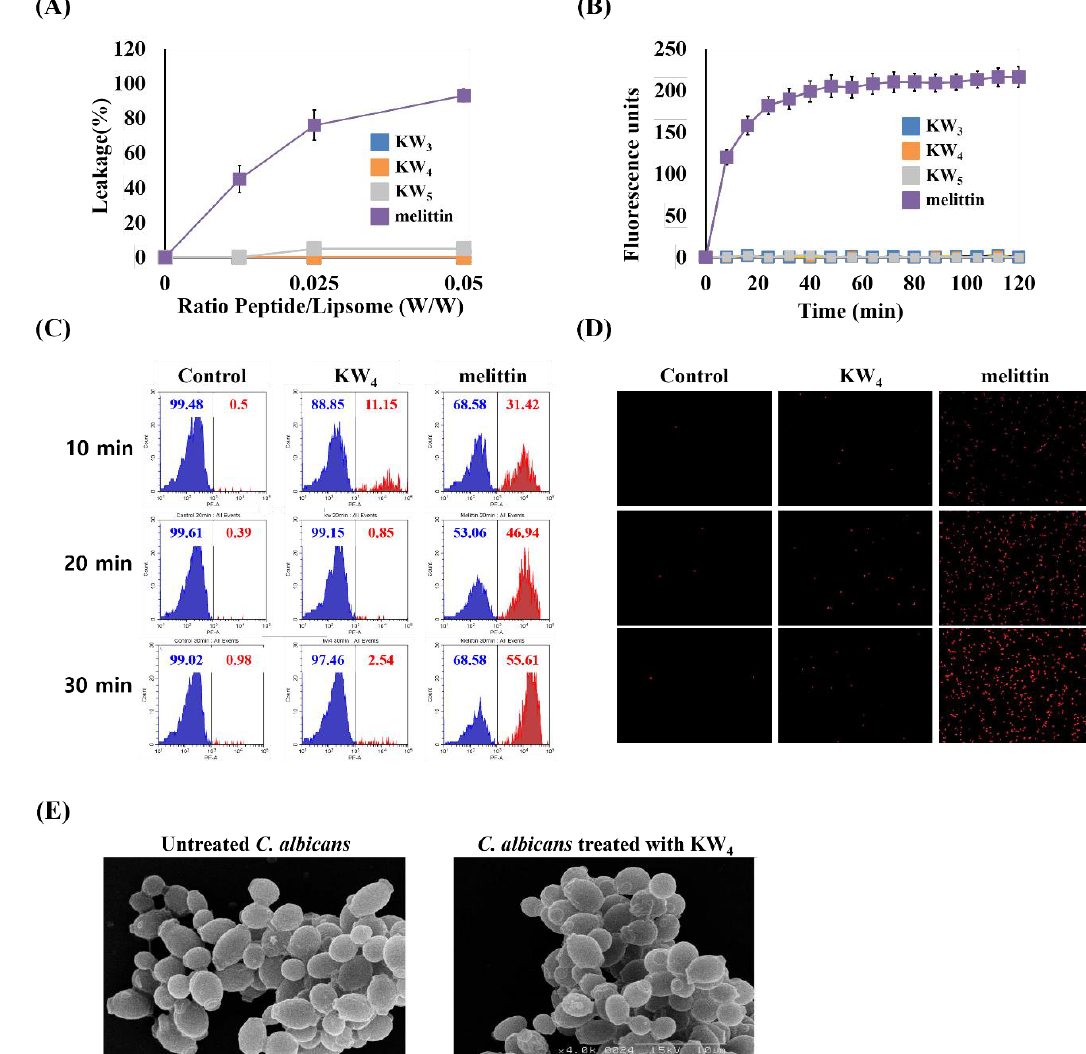
Figure 7. Lack of permeabilization of the cell membrane by the KW n peptides. ( A ) Calcein leakage by peptide in PE–PC–PI–ergosterol (5:4:1:2, w / w / w / w ) SUVs. ( B ) Analysis of membrane permeabilization caused by peptides using the SYTOX green dye. ( C ) Flow cytometry evaluation of the fungal membrane integrity using PI with KW 4 (8 μM) or melittin (4 μM). ( D ) Fluorescence microscopy of C. albicans stained with PI after treatment with peptides at 1× MIC for 10, 20 and 30 min. ( E ) SEM image of C. albicans treated with KW 4 at 1 × MIC. The error bars in panels A and B represent the SD, which was calculated from the average obtained for experiments performed in